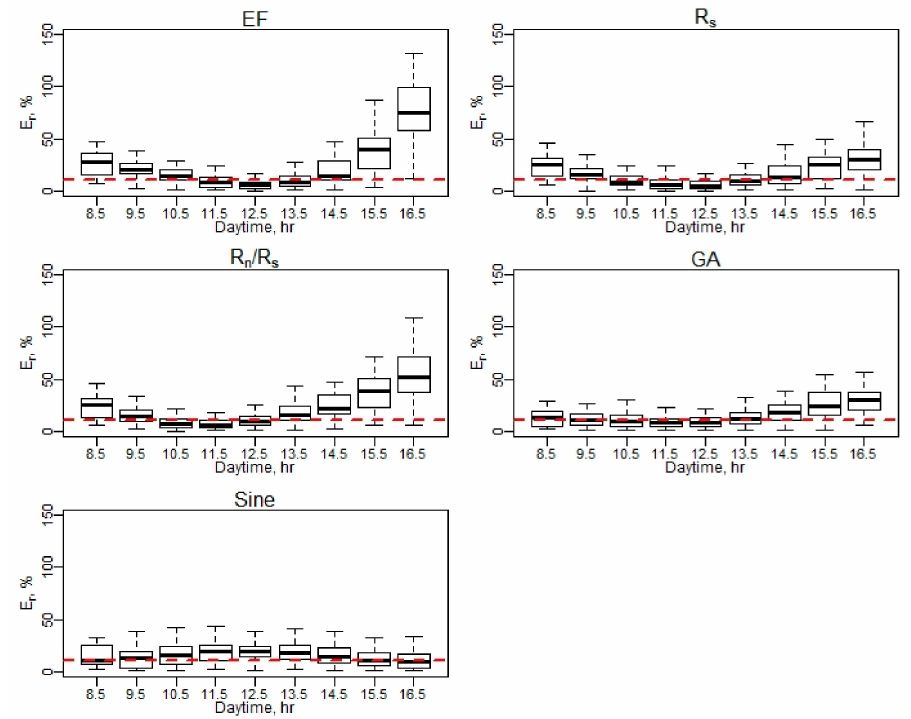
Figure A9. E r of daily EC ET (June–August).